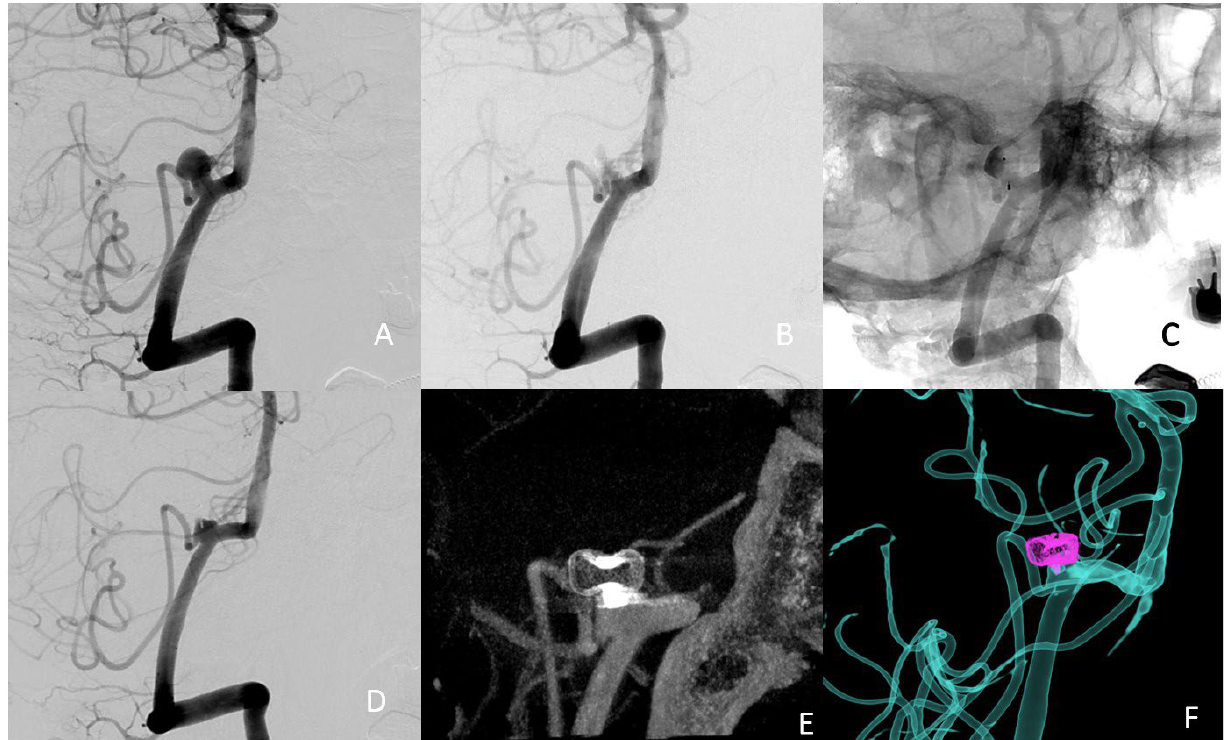
Figure 5. ( A ) preoperative treatment angle; ( B ) subtracted postoperative image; ( C ) nonsubtracted postoperative image, showing the stagnation of the contrast agent in the dome of the aneurysm, suggesting successful occlusion ( D ) 3-month follow-up treatment angle ( E ) 3-month follow-up 3D angio-CT ( F ) 3-month follow-up fusion